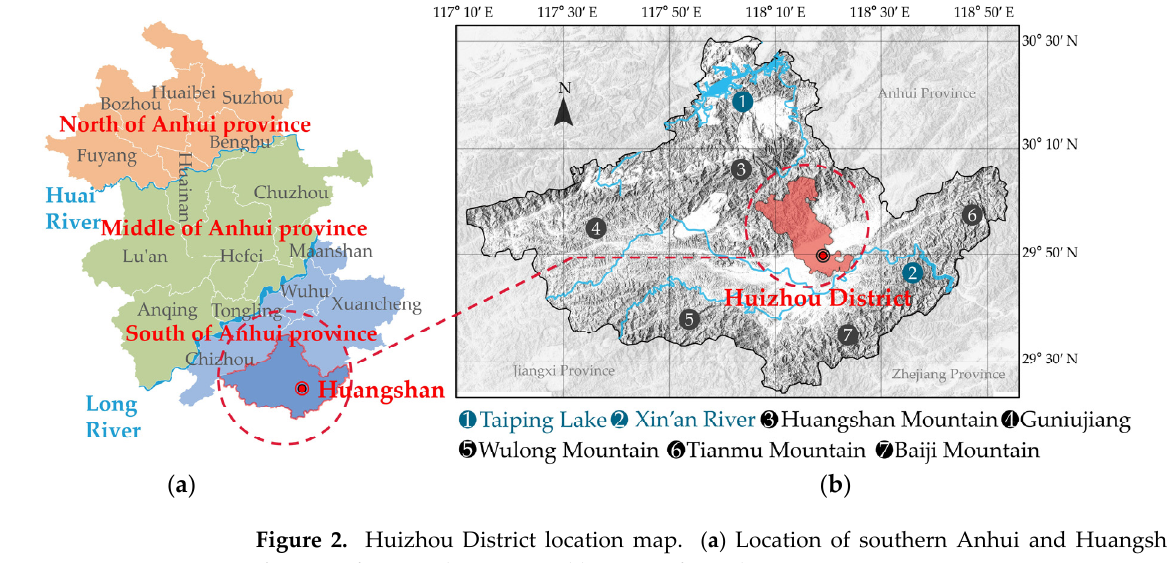
Figure 2. Huizhou District location map. ( a ) Location of southern Anhui and Huangshan city. ( b ) Map of Huangshan City and location of Huizhou District.